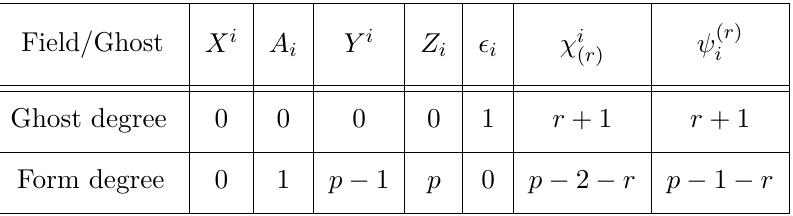
≡ χ i , ψ (0) ≡ ψ i , so that we use a i (0) = 0 , since this ghost ( p − 1)